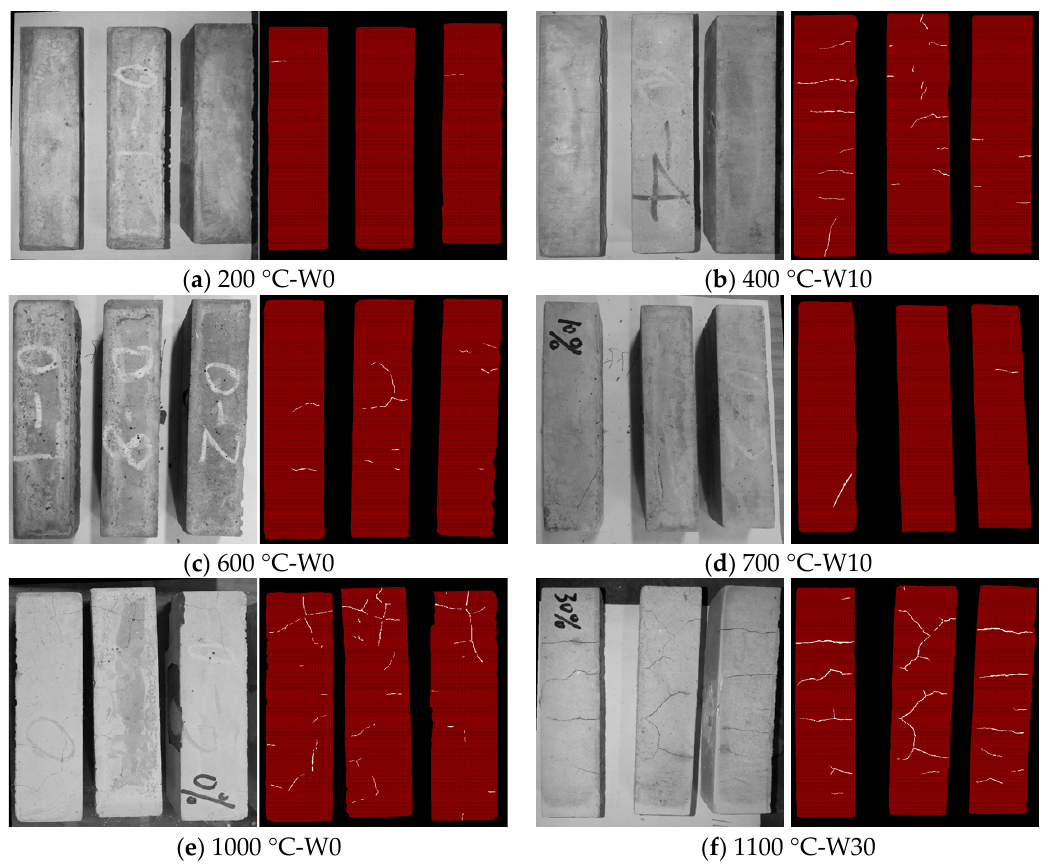
Figure 5. Crack annotation results of prism specimens with different treatment temperatures and raw material ratios; the treatment temperature and raw material ratio of ( a – f ) are 200 °C ‐ W0, 400 °C ‐ W10, 600 °C ‐ W0, 700 °C ‐ W10, 1000 °C ‐ W0, 1100 °C ‐ W30, respectively; left is original image; right is annotation result.